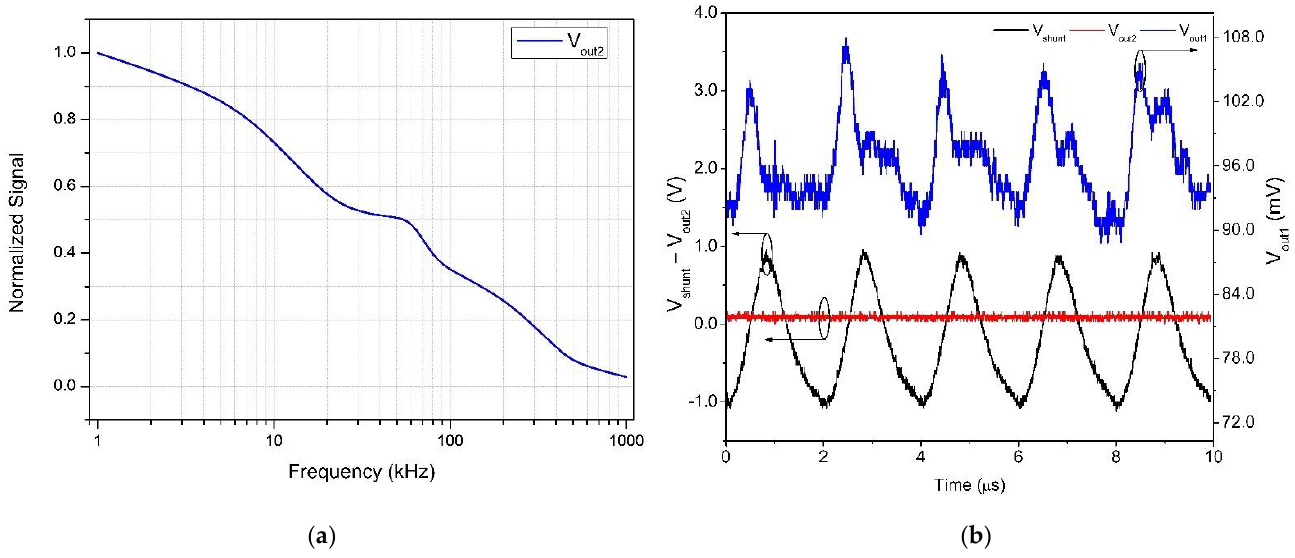
Figure 9. System response of the sensor for an input sinusoidal waveform at different frequencies. ( a ) Frequency response curve, demonstrating the circuit’s capability of responding to frequencies close to 1 MHz. ( b ) Black trace: a 500 kHz sinusoidal input current, measured on a 10 Ω shunt resistor. Blue trace: response of the system to a 500 kHz input (V out1 , Figure 1a). Red trace: RMS equivalent of the input current (V out2 ) (Black circles around curves indicate the applicable vertical